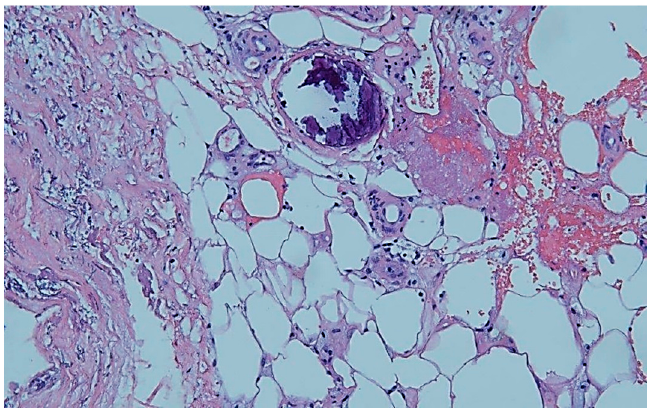
Figure 2. Histopathology: Typical calcification of a small vessel in the upper corium. By courtesy